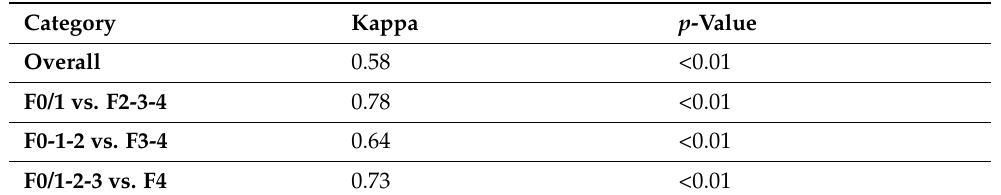
Table 3. Kappa coefficient index of agreement according to the different categories of liver fibrosis by both TE and SWE categorization.